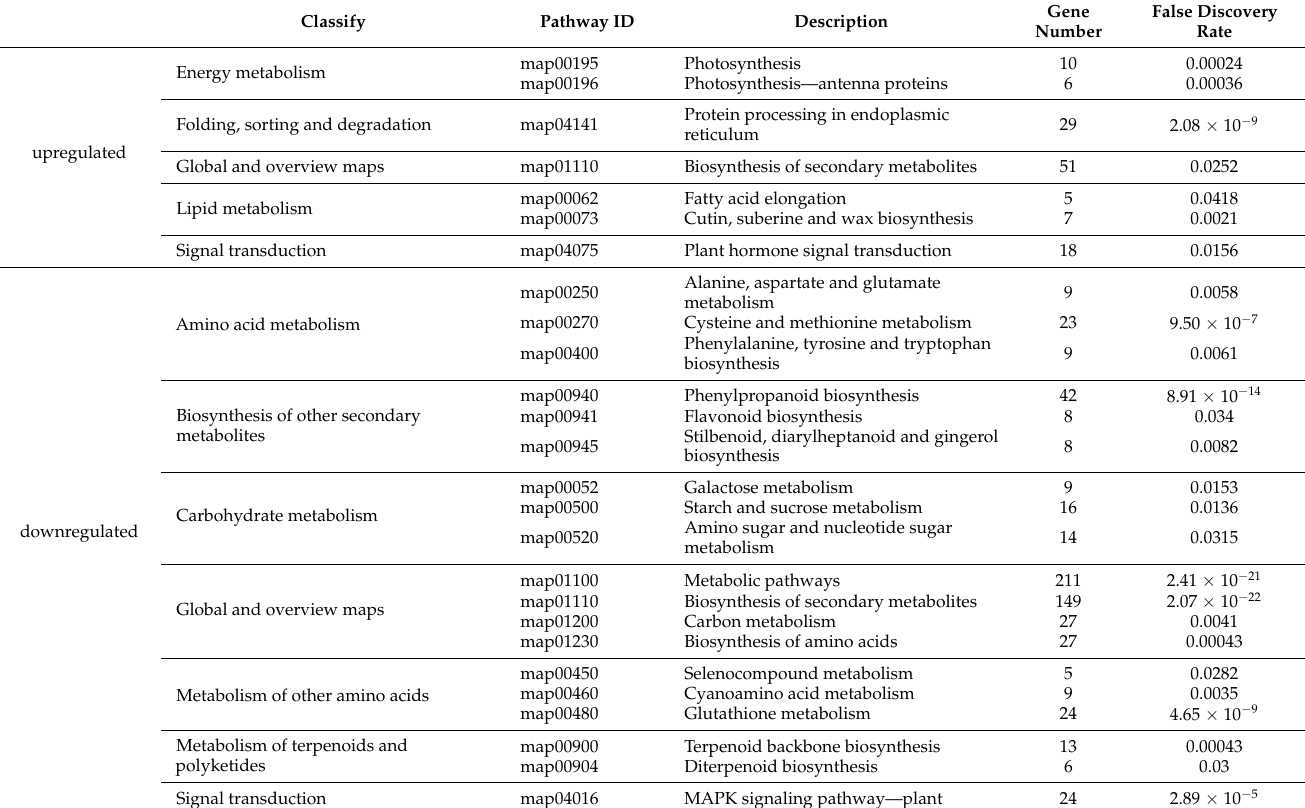
Table 1. KEGG pathway enrichment of